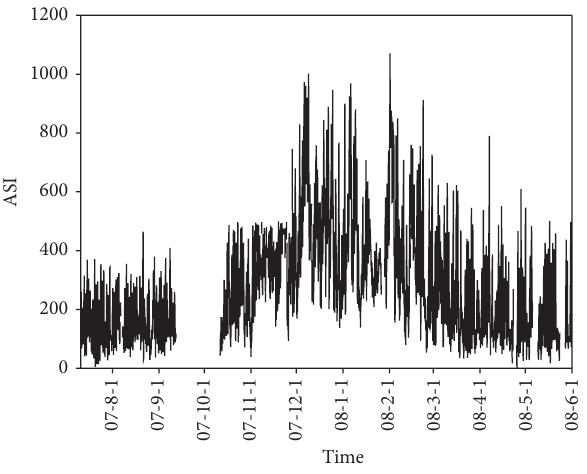
Figure 2: ASI measurement at station C (July 11, 2007, to May 31, 2008, data missing from September 12 to October 12, 2007, for instrument maintenance or error).